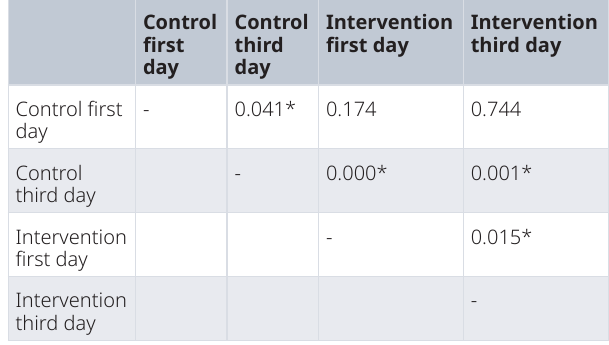
Table 4. Mann–Whitney results of Ca levels in the saliva of the control and intervention groups.